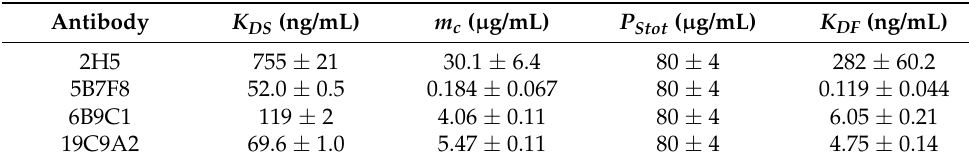
Table 1. Anti-Ana o 3 Monoclonal Antibody Binding Kinetics.